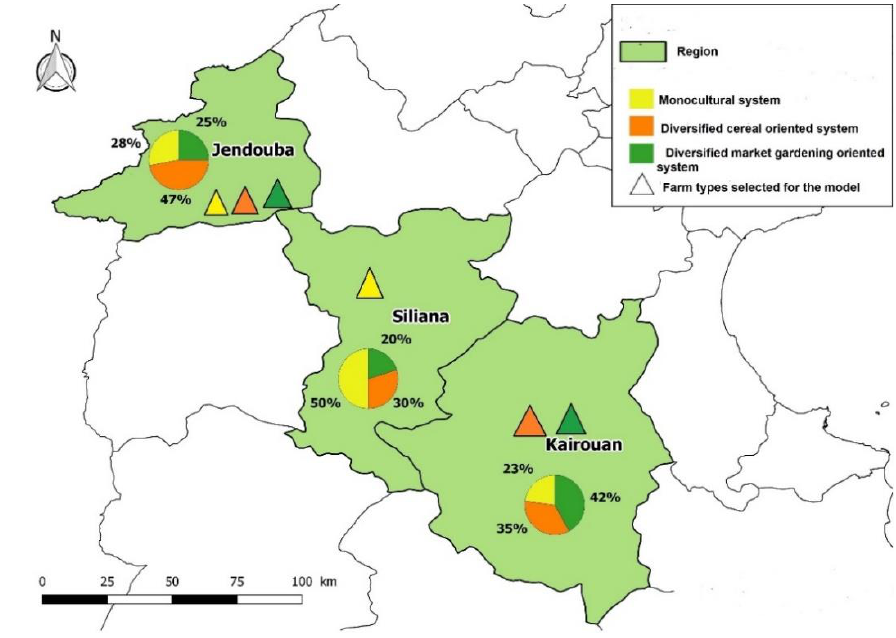
Figure 3. Distribution of farm types by region.